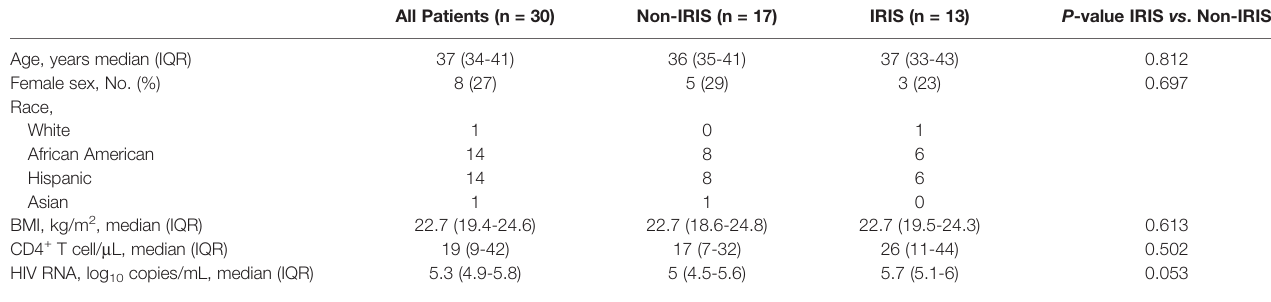
TABLE 1 | Baseline Demographic and Clinical Characteristics of Study